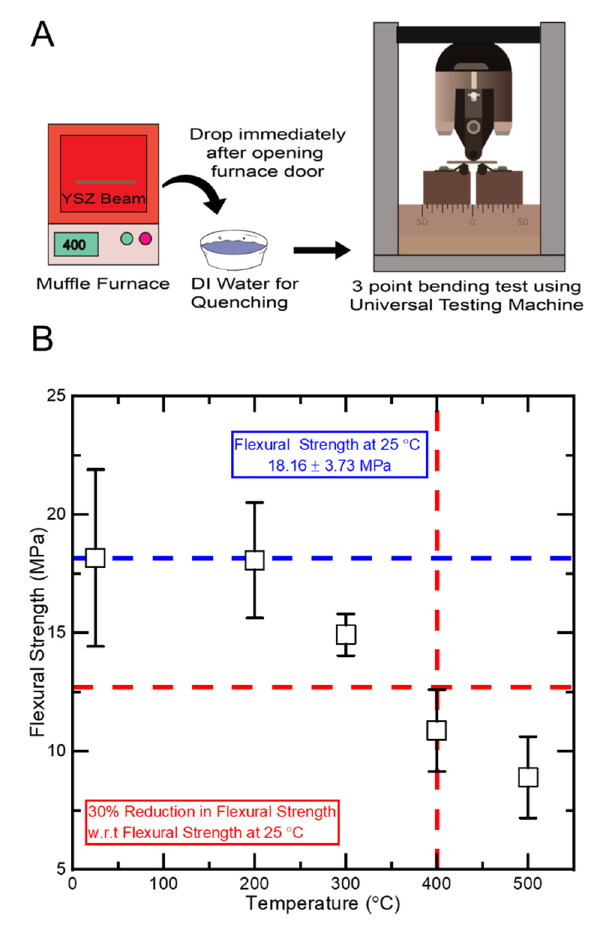
Figure 4. ( A ) The schematic shows the thermal shock experiment and the subsequent mechanical testing of porous YSZ. ( B ) Flexural strength of YSZ beams after thermal shock at the temperature range of 200 °C to 500 °C. The horizontal lines show the mean value of strength for room temperature (top line) and the 30% reduction point with respect to the top line (bottom line).